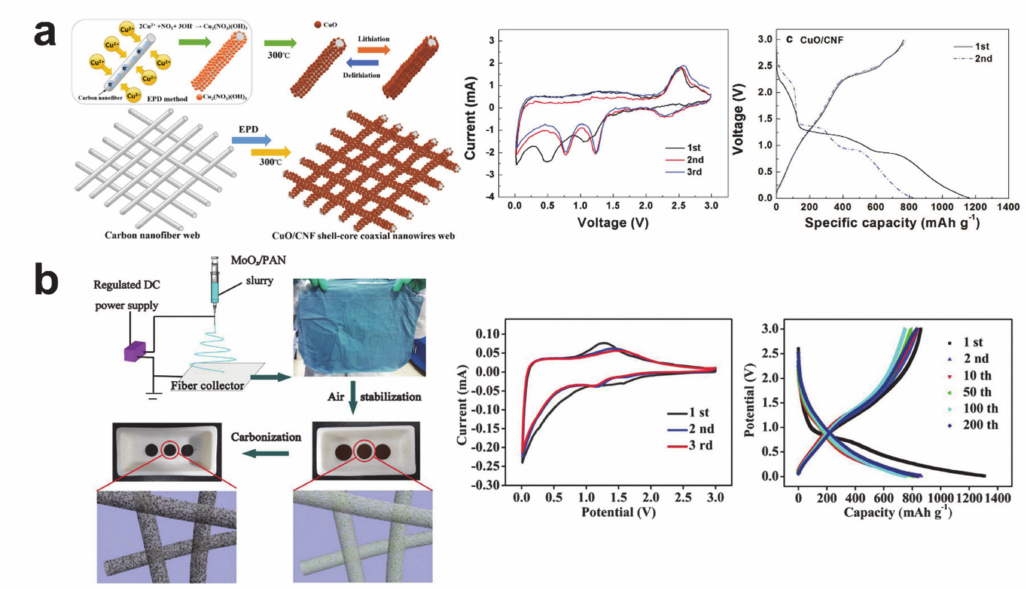
Figure 11. Fabrication process and electrochemical performances of other important carbon composite anode materials. ( a ) CuO / carbon composite nanofiber (reprinted with permission from [140]; copyright 2015 Springer Nature) and ( b ) MoO 2 + δ / carbon composite nanofiber (reprinted with permission from [145]; copyright 2016 Royal Society of